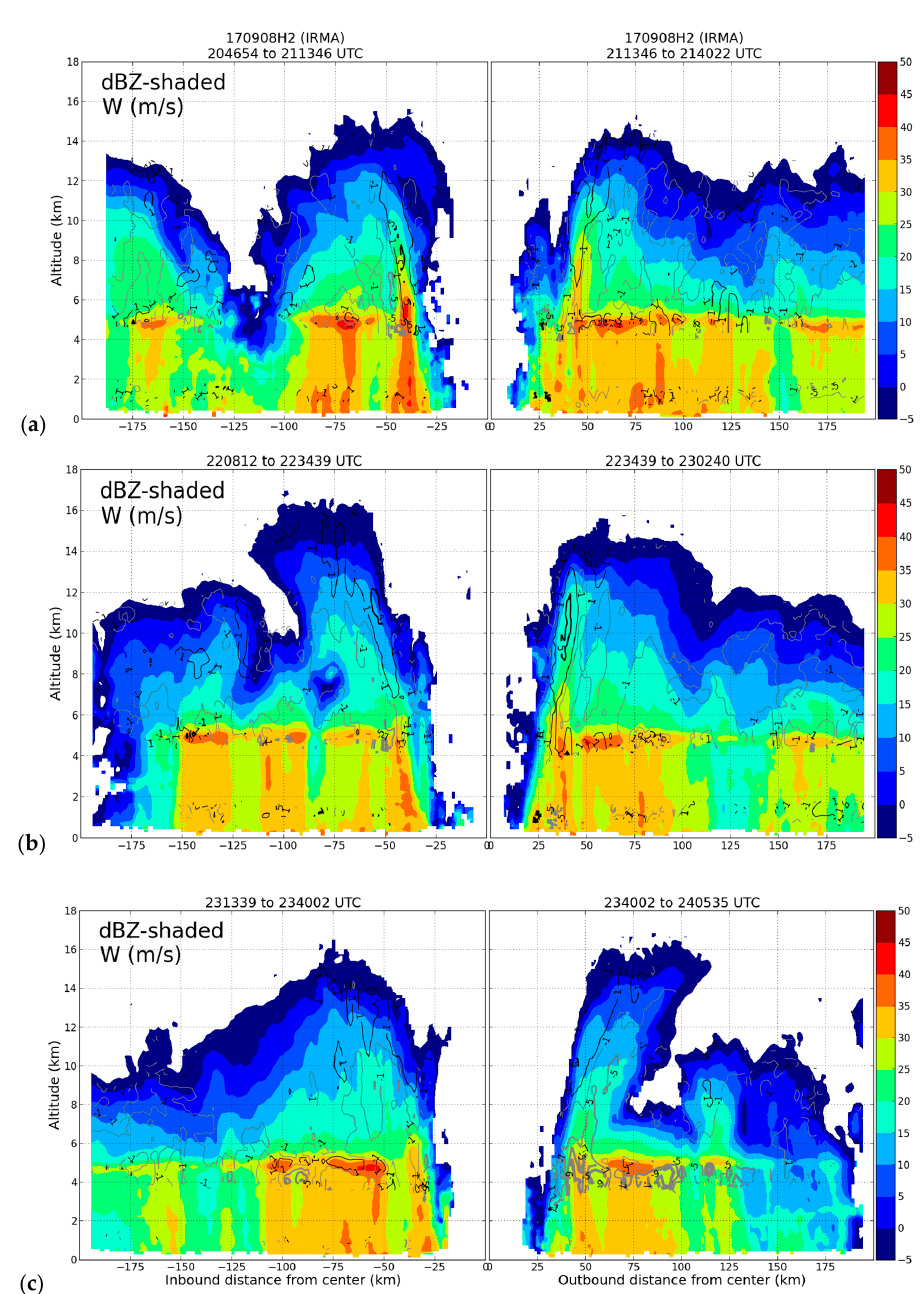
Figure 1. Vertical cross sections of Hurricane Irma (AL112017) for three di ff erent aircraft passes through the storm’s rotating center on 8 September 2017: ( a ) 20:46:54–21:40:22 UTC, ( b ) 22:08:12–23:02:40 UTC, ( c ) 23:13:39–24:05:35 UTC [20]. These passes are used to determine the upper and lower bound approximations in the vertical dimension.